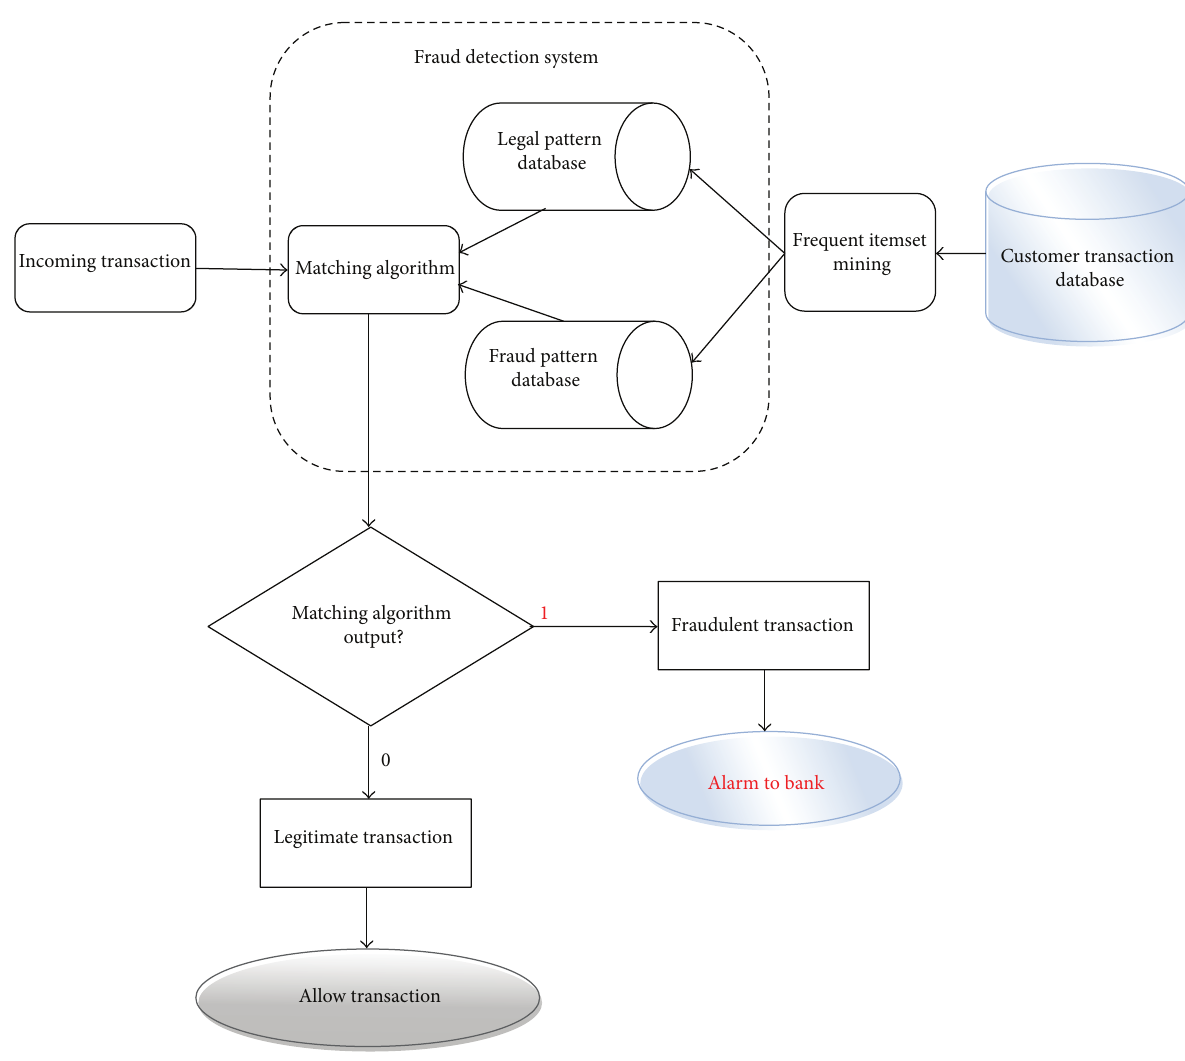
Figure 1: Proposed credit card fraud detection